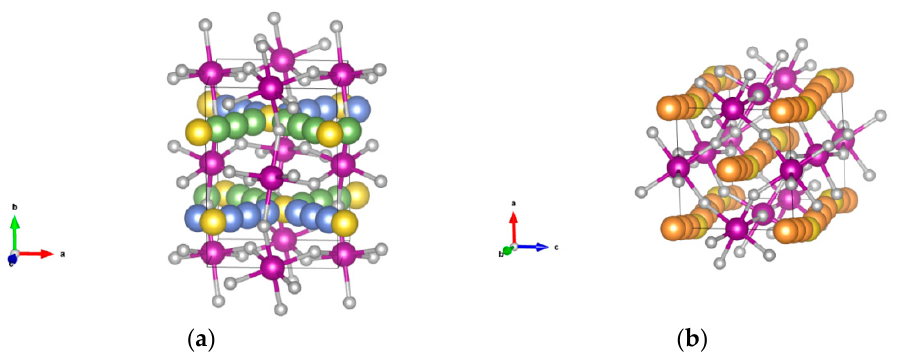
Figure 8. Schematic representation of the Na-ion migration paths for NaMnF 3 : ( a ) path A1 in green and path A2 in blue; ( b ) path B in orange. Legend: Na is indicated in yellow; Mn is indicated in purple; F is indicated in grey.